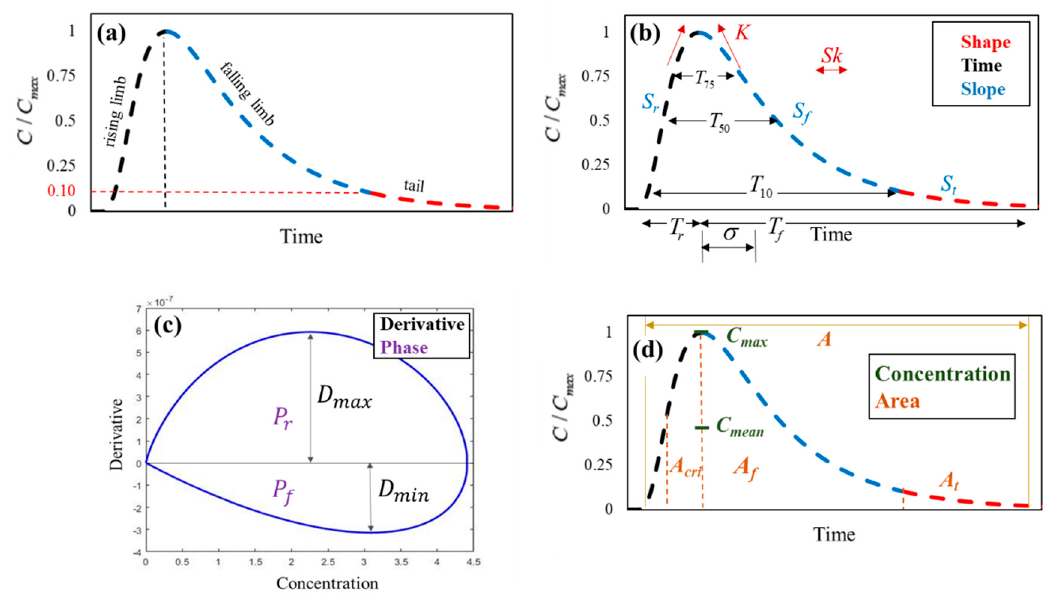
Figure 2. ( a ) Typical BTC and BTC features for ( b ) shape, time, and slope, ( c ) derivative and phase, and ( d ) concentration and area. Table 2. Symbols and descriptions of BTC